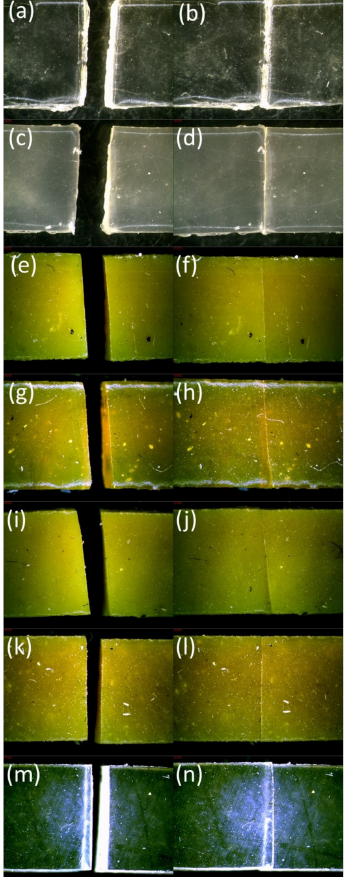
Figure 8. Pictures of samples after damage and after sudden healing of the damaged surfaces as a result of self-adhesion: pure ENR-50 sample after cutting ( a ) and after healing ( b ), ENR/silica15 com- posite after cutting ( c ) and after healing ( d ), ENR/quercetin2 sample after cutting ( e ) and after healing ( f ), ENR/quercetin2/silica15 composite after cutting ( g ) and after healing ( h ), ENR/quercetin4 mate- rial after cutting ( i ) and after healing ( j ), ENR/quercetin4/silica15 composite after cutting ( k ) and after healing ( l ), ENR/DCP2 composite after cutting ( m ) and after healing ( n